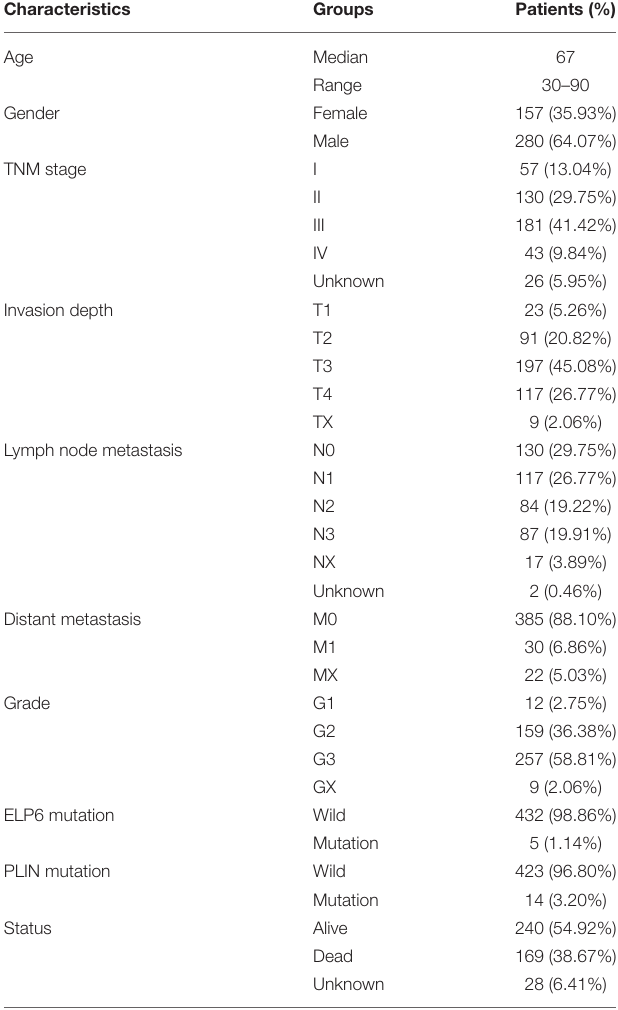
TABLE 1 | Clinicopathological characteristics of TCGA patients with gastric